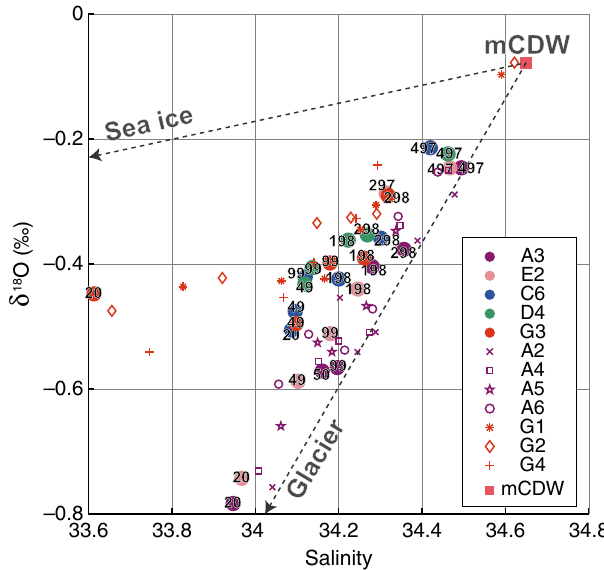
Fig. 3 Glacial meltwater signals on T-S space. Temperature-salinity relationships at fi ve trough stations (Sta.A3, E2, C6, D4, and G3) with the northeast slope region (Sta.X31, shown by gray symbols). Two dashed diagonals denote theoretical mixing lines ( “ Gade line ” ) 20 between glacier (ice) and observed mCDW temperature maxima (at Sta.A3 at the SGT ice front and Sta.X31 on the northeast slope region). Horizontal dashed line is the freezing point of seawater at atmospheric pressure. Numbers 1, 3, 5, 7 beside the large symbols indicate pressure levels at 100, 300, 500, and 700 dbar, Alongshore wind speed from the ERA-Interim reanalysis on the northeast continental slope (see their grid locations in Fig. 1a) shows a clear seasonal variation, which is intensi fi ed in autumn and weakened in summer (Fig. 7a), as previously demonstrated 19 .